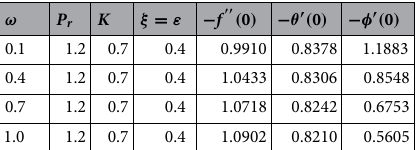
Table 3. Numerical values of Sherwood numbers for various values of ω .